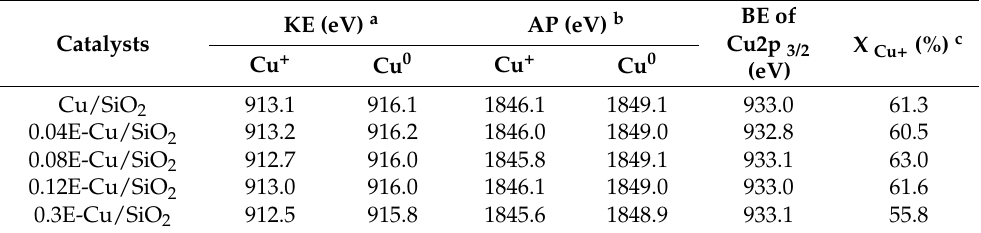
a Kinetic energy. b Auger parameter. c Intensity ratio between Cu + and (Cu + + Cu 0 ) by deconvolution of Cu LMM